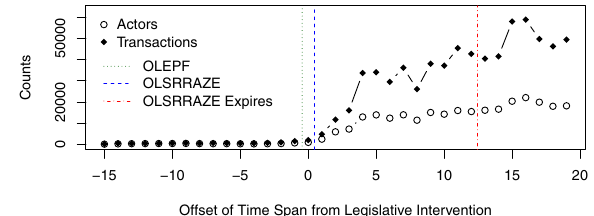
Fig. 3 Actors and total number of transaction counts. Temporal representation of the number of actors (circles) and transactions (diamonds) for 30-day spans. After the tax-incentives laws (span 0), more actors and transactions appeared. At the termination of the MM project, more agents and transactions appear, users are taking advantage of the incentives for the last time and using what they had left in their MM